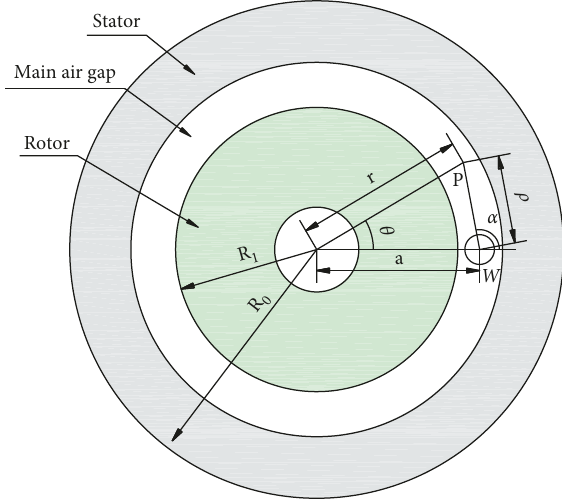
Figure 5: Simplified magnetic field model of single armature winding of